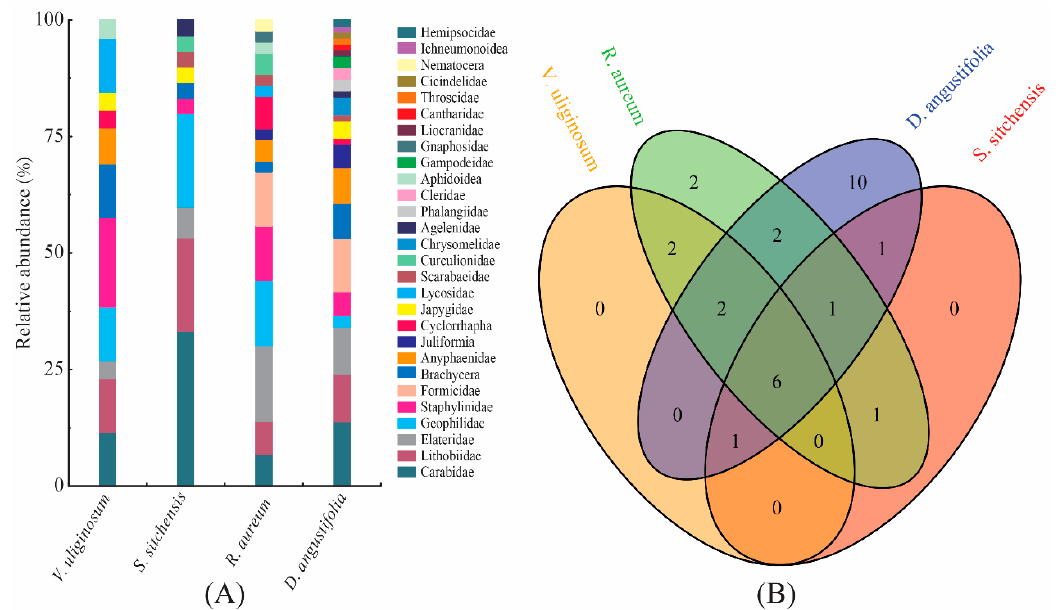
Figure 1. Soil macro-arthropods community composition in the habitats. ( A ) Relative abundance of the soil macro-arthropods community; ( B ) Venn diagram of the number of shared and unique arthropod taxa in the different habitats. Shared and unique numbers in the circles indicate either unique number of taxa or number of shared taxa in the overlap regions.